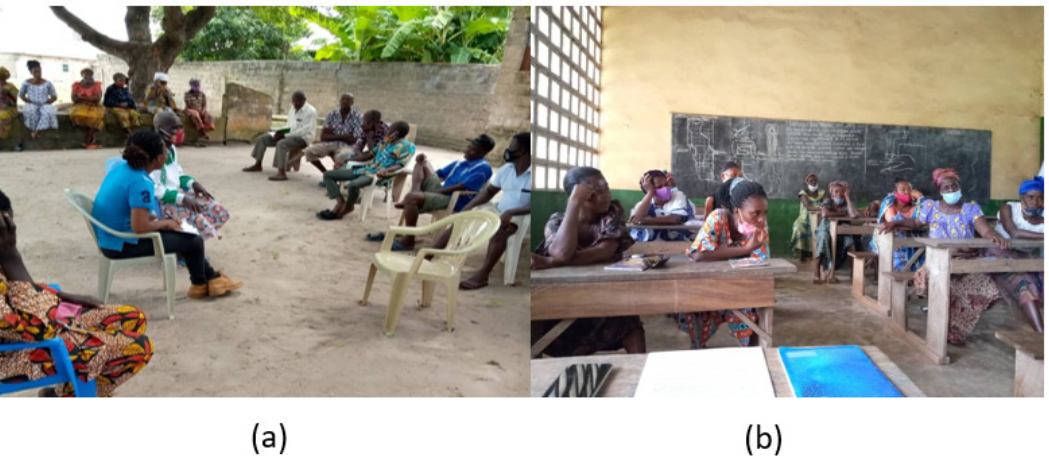
Figure 3. ( a ) Focus group discussion in Agbanakin and ( b ) ARDI workshop in Batonou with local communities ( own photo).